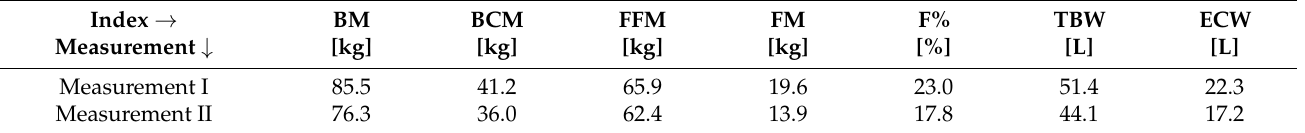
Table 1. Anthropometric indices.